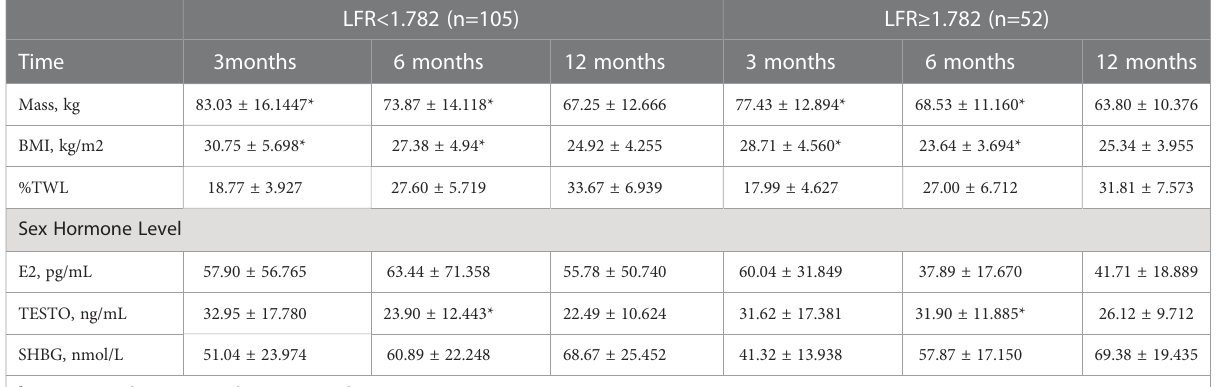
TABLE 7 Association with postoperative indicators at 3, 6 and 12 months according to the cut-off value of